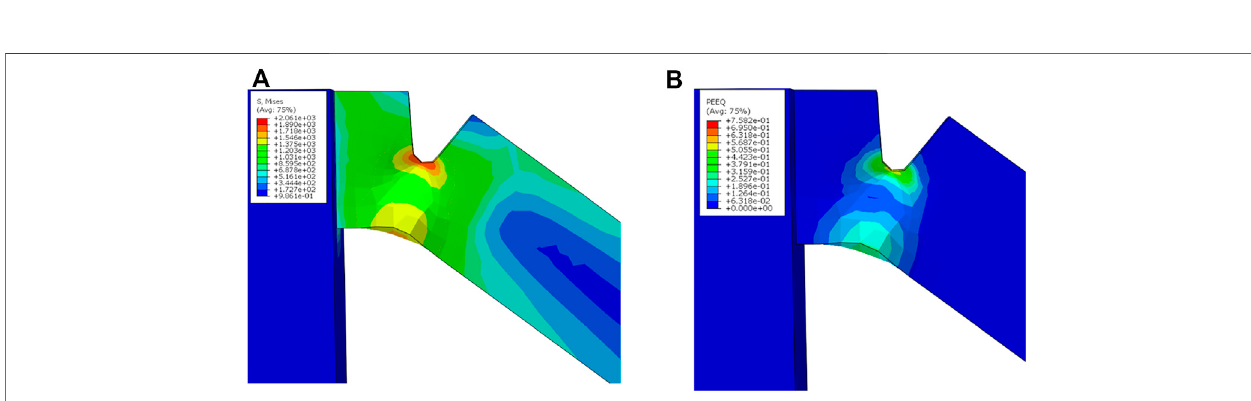
Frontiers in Materials |